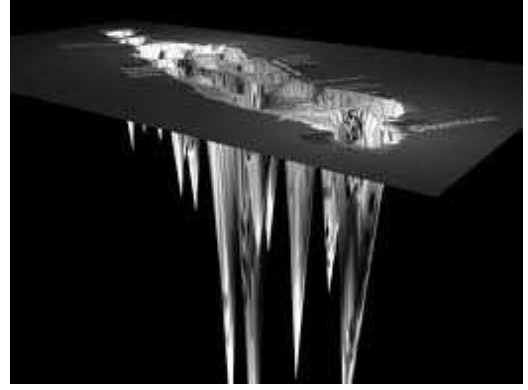
Fig. 3; Crimescape in New York, http://www.nadiaamoroso.com